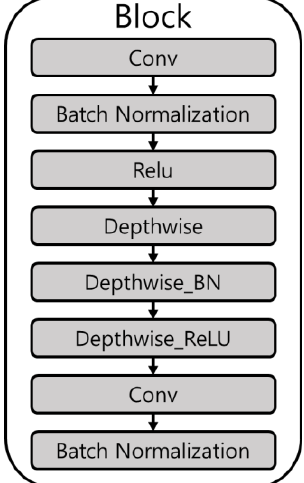
Figure 8. Block included in MobileNetV2. The block performs the resize process and convolution of